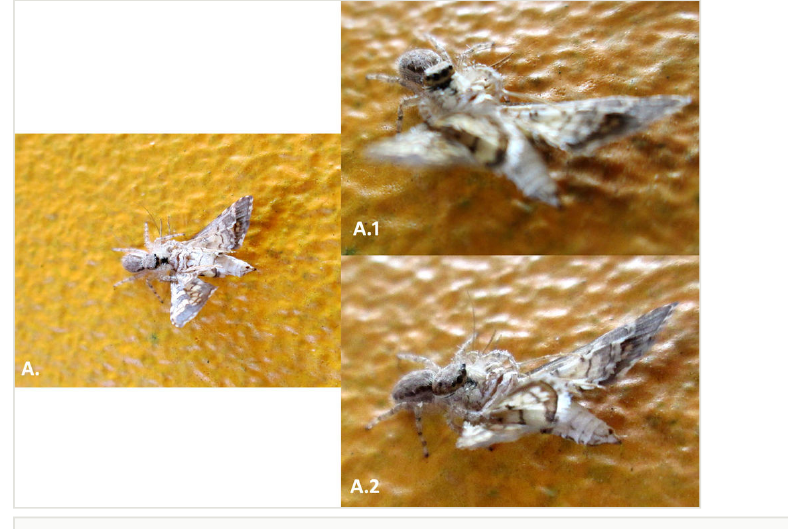
A female of Pelegrina variegata Pickard-Cambridge F., 1901 predating Samea ecclesialis Guenée, 1854 perched on the walls of the Gehry's Biodiversity Museum.